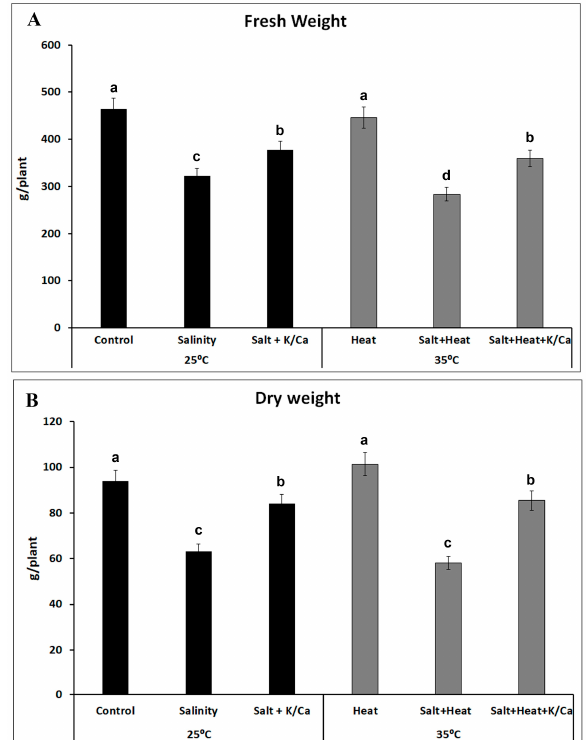
Figure 1. Fresh ( A ) and dry weight ( B ) of tomato plants grown under control, salinity (60 mM NaCl) or salinity and higher concentration of K + and Ca 2+ in the irrigation solution at optimal temperature (25 ◦ C) or heat stress (35 ◦ C). Data represent means ± SE ( n = 6). Bars with di ff erent letters within each (25 °C) or heat stress (35 °C). Data represent means ± SE ( n = 6). Bars with different letters within each panel represent data with significant di ff erences at p < 0.05 (Turkey panel represent data with significant differences at p < 0.05 (Turkey HSD).